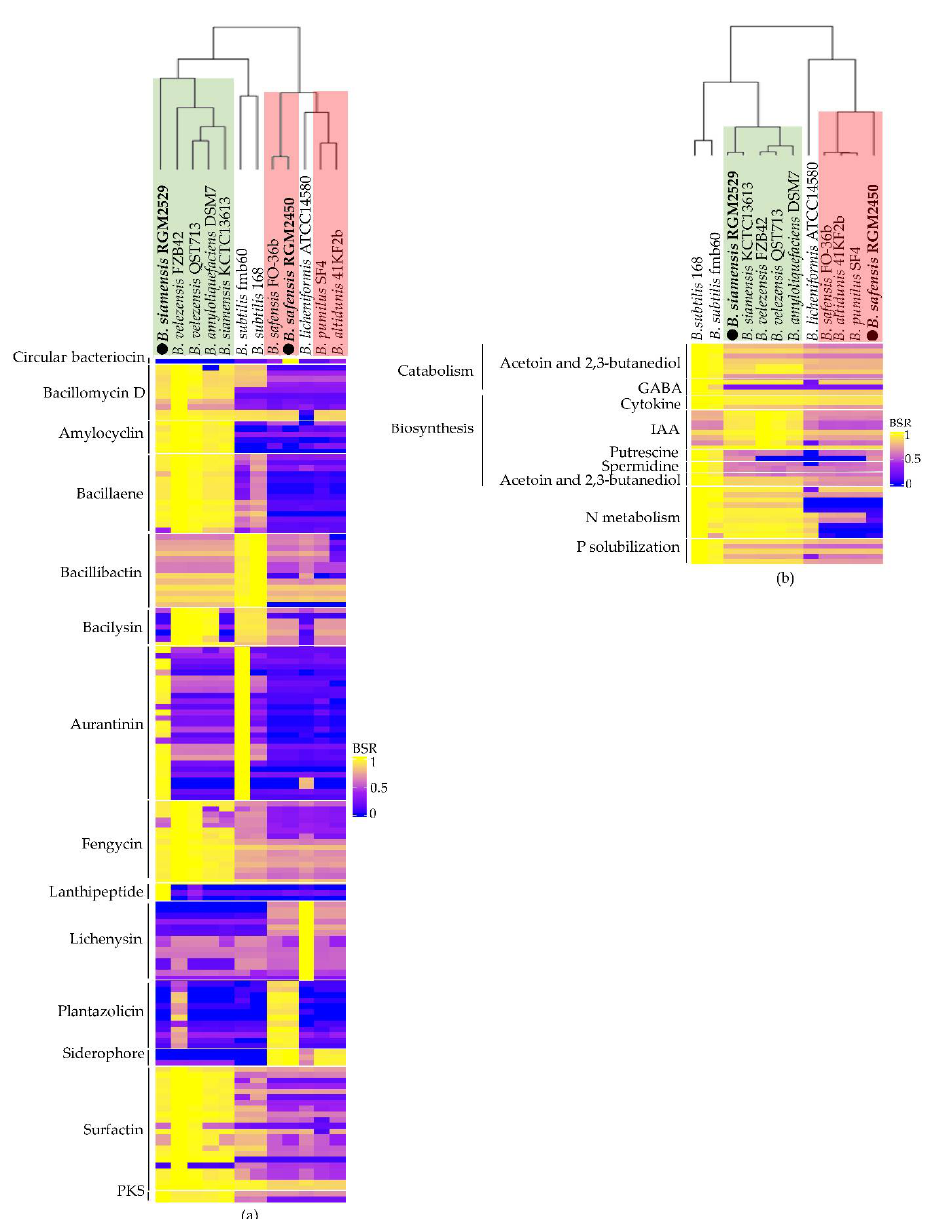
Figure 2. Heat maps displaying the homology levels of genes encoding PKS, NRPS, PKS-NRPS, bacteriocins and plant-growth promotion factors between B. safensis RGM 2450 and B. siamensis RGM 2529 strains and other Bacillus spp. strains described as PGPR. A score of 1 indicates a perfect match, while a score of 0 indicates no BLAST match of a query gene in the reference genome. Values over 0.4 indicate the presence of a homologous gene. ( a ) Comparative analyses of NRPS, PKS and bacteriocin genes participating in the biosynthesis of biocontroller factors. ( b ) Comparative analyses of genes encoding plant-growth promotion factors. The strains that belong to B. amyloliquefaciens and B. pumilus group are highlighted in green and red,